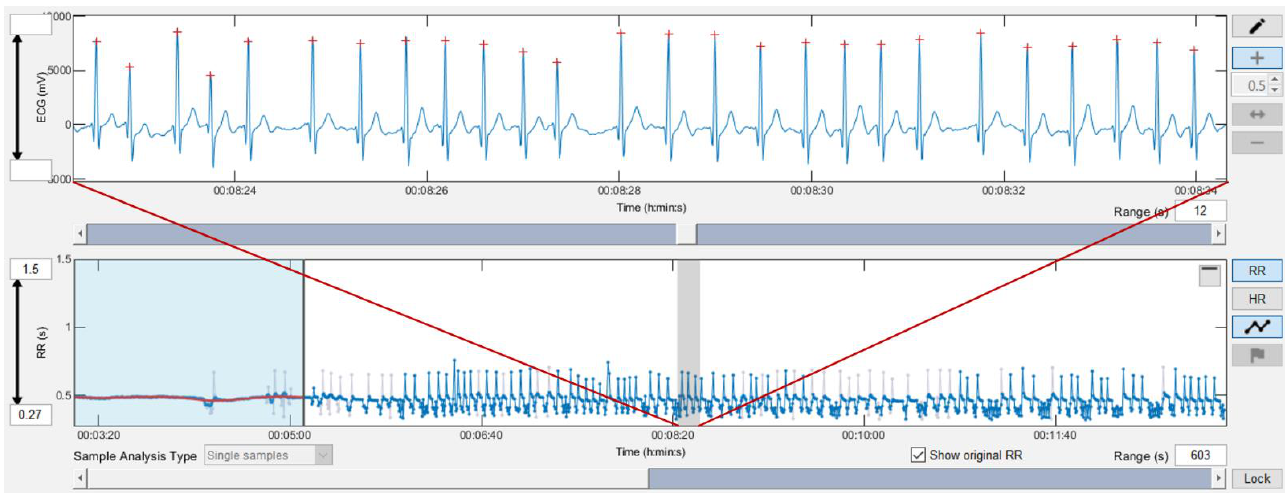
Figure 8. RR interval data during low intensity cycling exercise in one participant recorded with the Movesense Medical chest belt device. The single channel ECG showed excellent waveform quality but frequent atrial premature beats with runs of sustained atrial fibrillation. The data were analyzed with Kubios HRV Premium software Version 3.5.